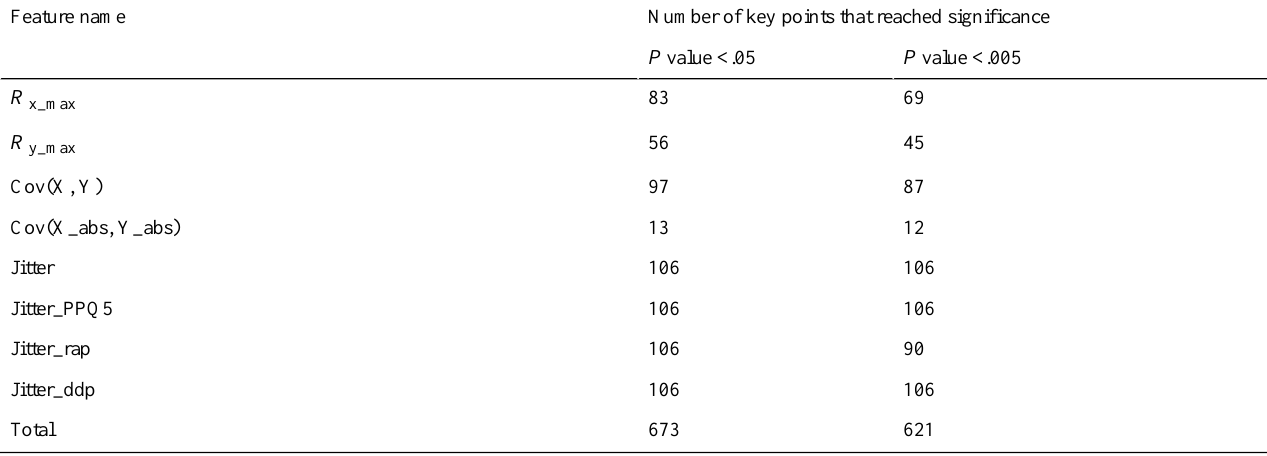
Table 4. Number of points that reached significance for each feature type.